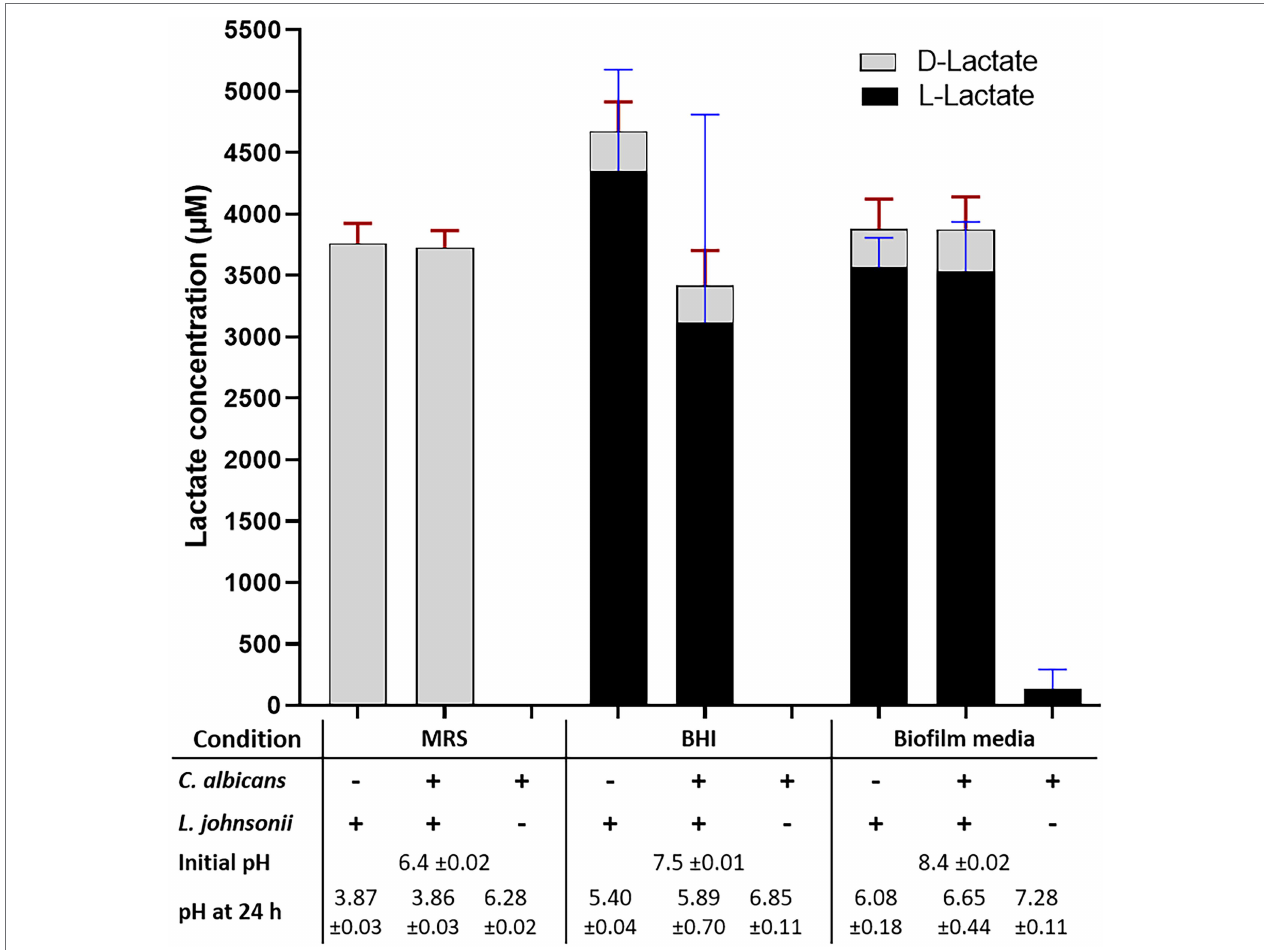
FIGURE 3 | Lactate production and pH on different culture media. The production of DL-lactate by the MT4 strain was measured in various growth media. The growth media influence DL-Lactate production and ratio. In MRS, the D enantiomer is favored, while the L enantiomer production takes over in BHI and biofilm media. Acidification of the culture media does not correspond to the total DL-lactic acid concentration, which may be due to the particular buffering capacity of each growth media and the presence of other organic